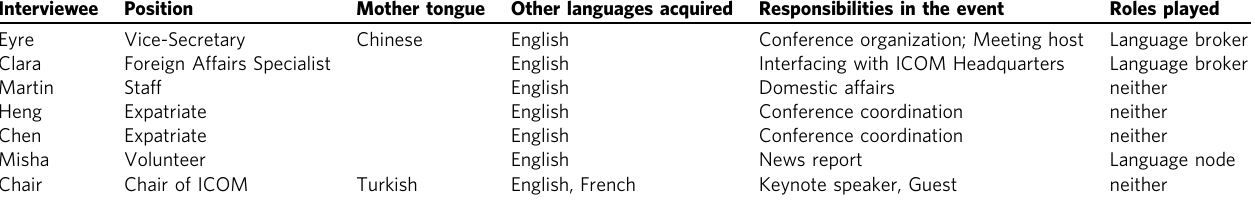
Table 2 Information of interviewees.